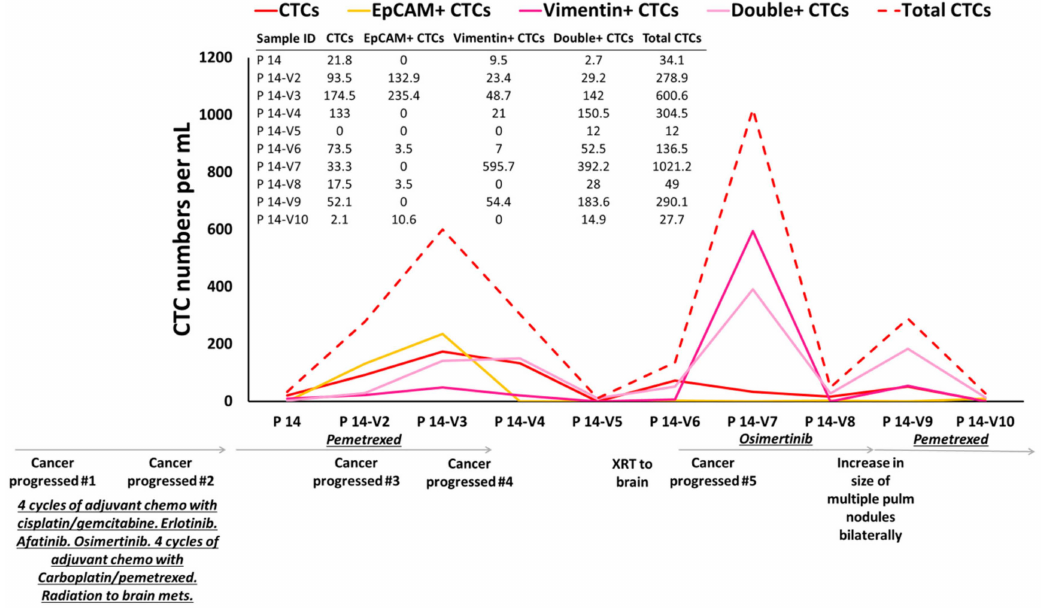
Figure 6. CTC enumeration of one NSCLC patient over the treatment regime. In total, 10 di ff erent follow-up samples from patient P 14 were collected and the CTC numbers were evaluated over di ff erent treatments. According to the available clinical information, the CTC numbers tracked the patient’s outcome over the course of